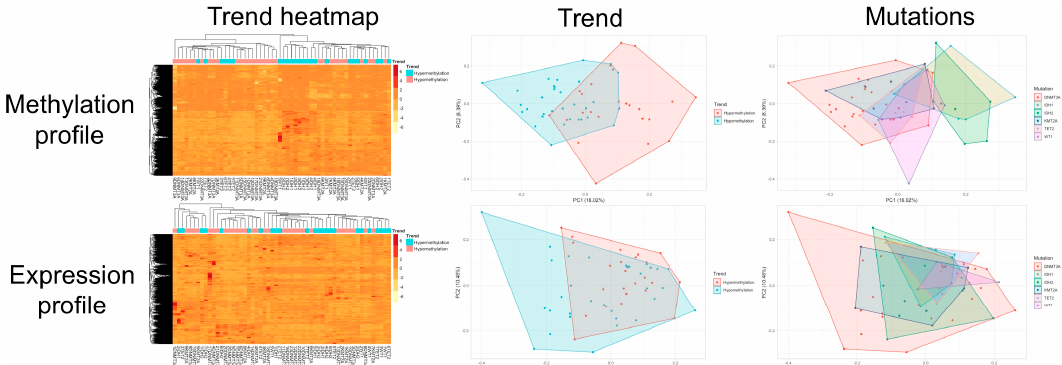
Figure 3. Heatmap and principal component analysis (PCA) representation of methylation and expression profiles. For methylation profile, the gene methylation score was used, while for expression profile, the transcript levels were used. The dendrograms show potential clustering (horizontal: between cases; vertical: between genes).